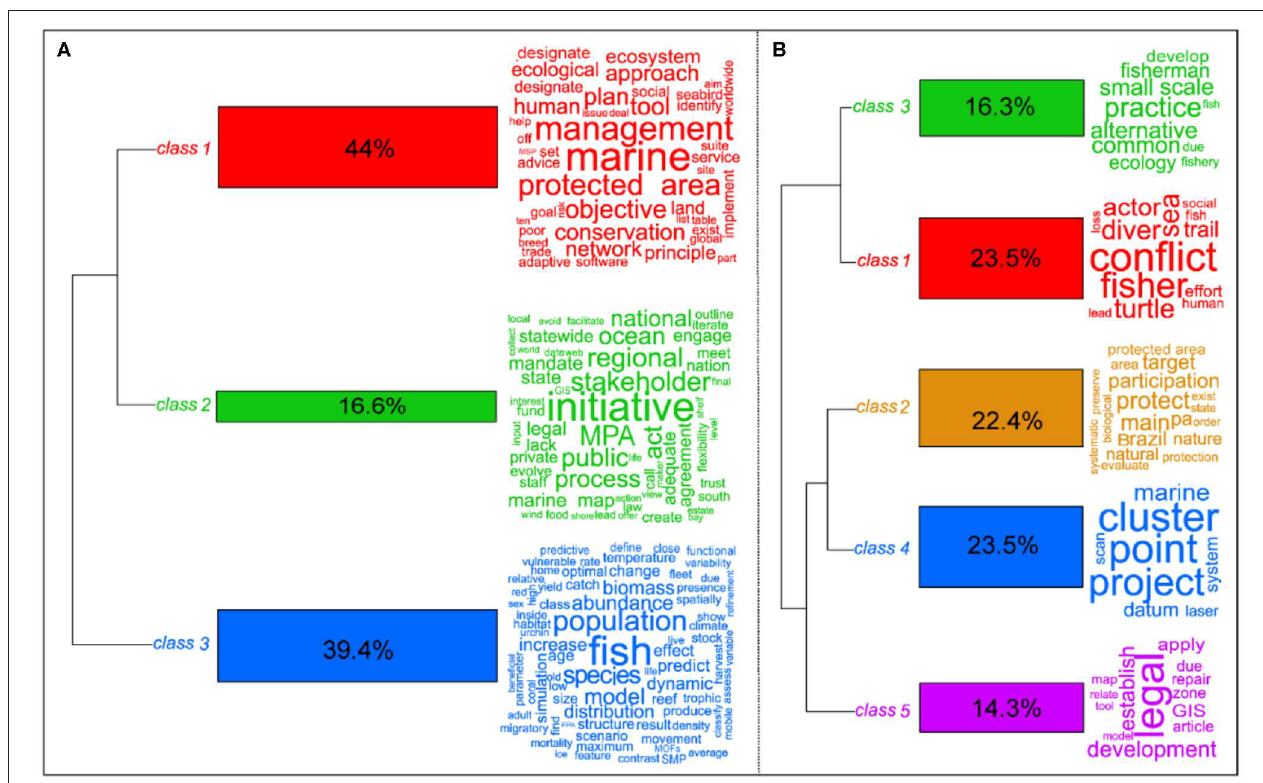
FIGURE 8 | Semantic classes of studies (A) outside and (B) in Brazil (including the local case study for this specific analysis). The classes are divided according to the proximity of the words in the studies. These classes are based on the cluster analysis that uses the distance between the words in the text to define similarities or differences. The dendrogram represents the grouping based on this distance between the